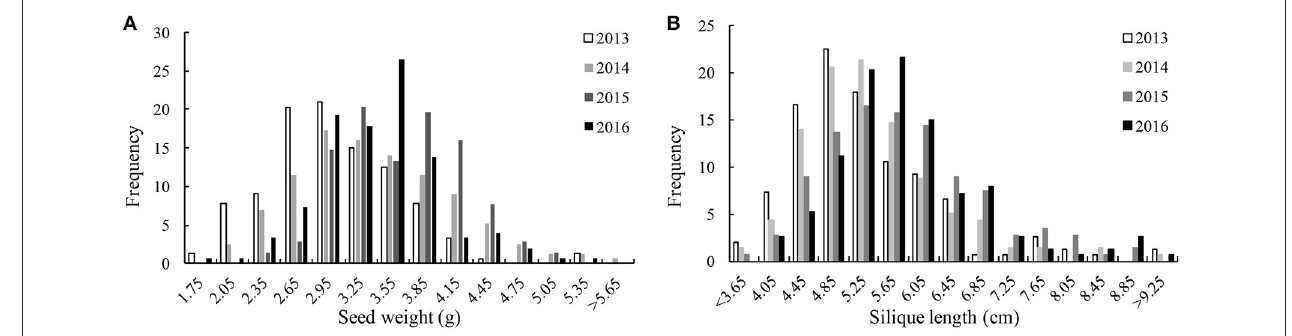
FIGURE 1 | Distribution of seed weight and silique length in 4